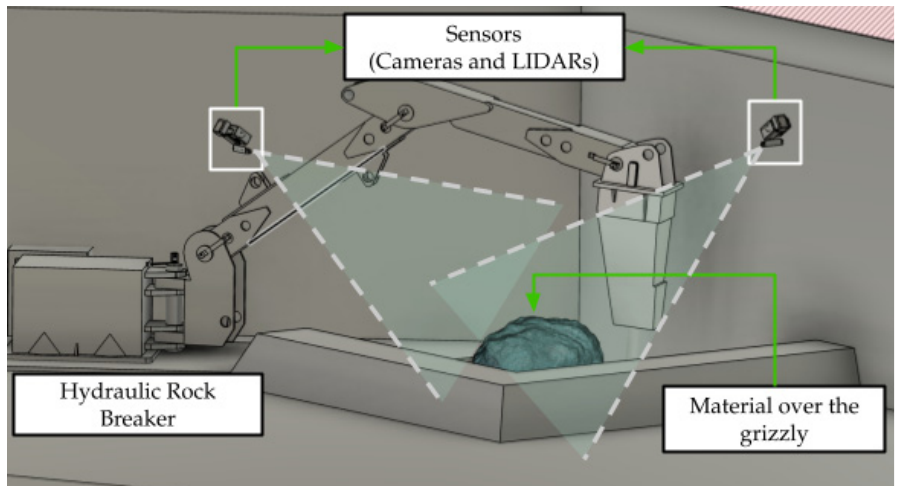
Figure 1. A rock breaking hammer environment with sensors, which includes: A hydraulic rock breaker, a grizzly with material, and sensors pointing to the working area.